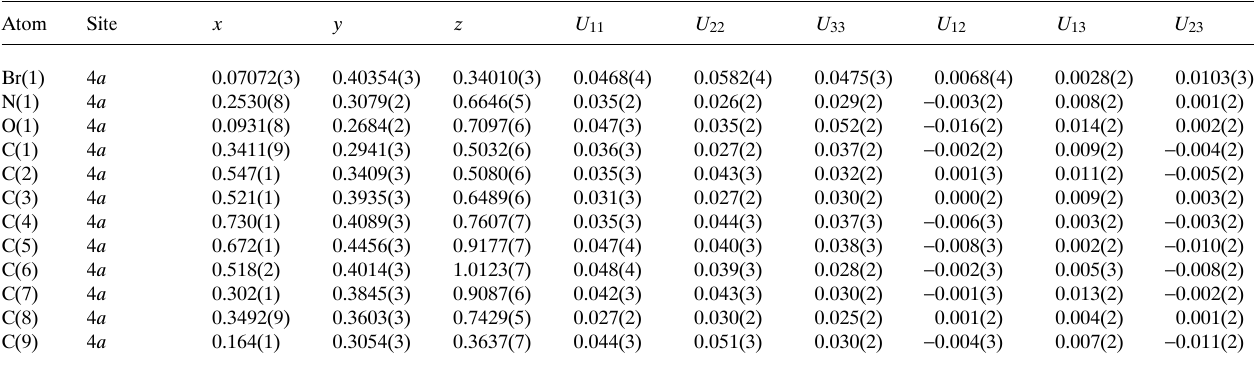
Table 3. A tomic coordin a tes a nd displ a cement p a r a meters (in Å 2 )